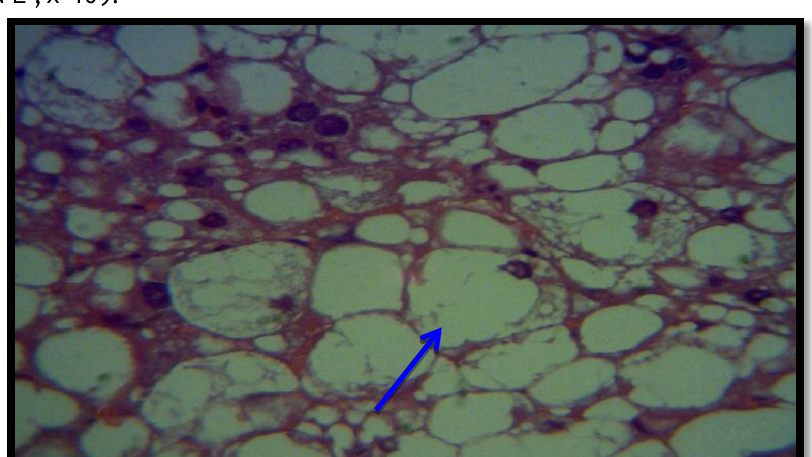
Figure (3):- Histological section in the liver of rat received 1 ml / kg B.W. of CCL4 with olive oil, shows severe vacuolation in the hepatocyte (H and E, x